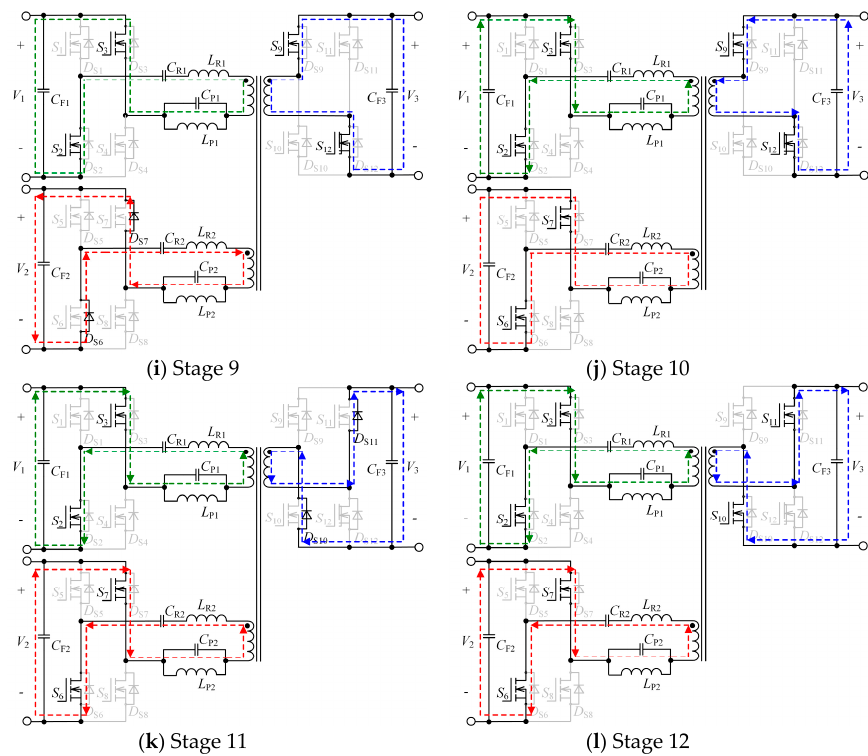
Figure 4. Equivalent circuits of each stage.